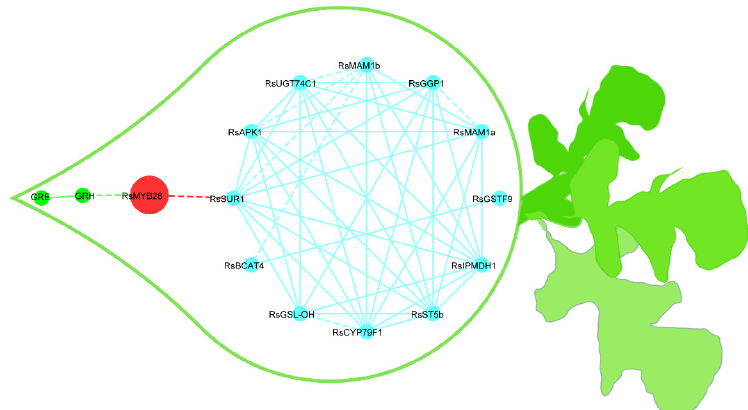
Figure 5. Putative metabolic network for the synthesis of GSLs in radish fleshy taproots. The blue lines represent the relationships among GSLs biosynthesis genes; the red lines represent the relationships between RsMYB28 and GSLs biosynthesis genes; the green lines represent the relationships between genes and GSLs. The correlation strength according to the r coefficient ranges was used to determine whether the lines are shown as solid or dashed (dashed: 0.7 ≤ r ≤ 0.85; solid: r > 0.85). The red nodes represent transcription factors, the blue nodes indicate GSLs biosynthesis genes, and the green nodes are GSLs.